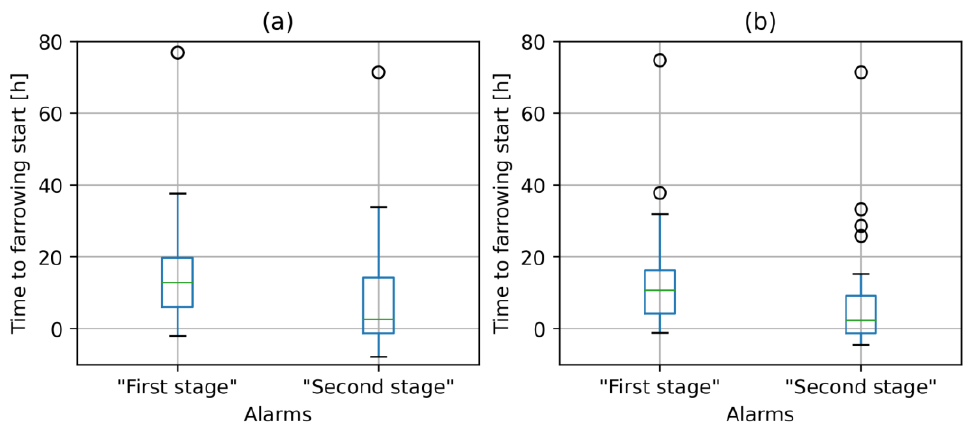
Figure 6. Distribution of duration between the time of alarms and beginning of farrowing. Circles indicate outliers. ( a ) Centroids of sows were extracted with YOLOX-medium trained in experiment 1. ( b ) Centroids of sows were extracted with YOLOX-large trained in experiment 2. The activity of sows was estimated on images sampled in 1 fps.